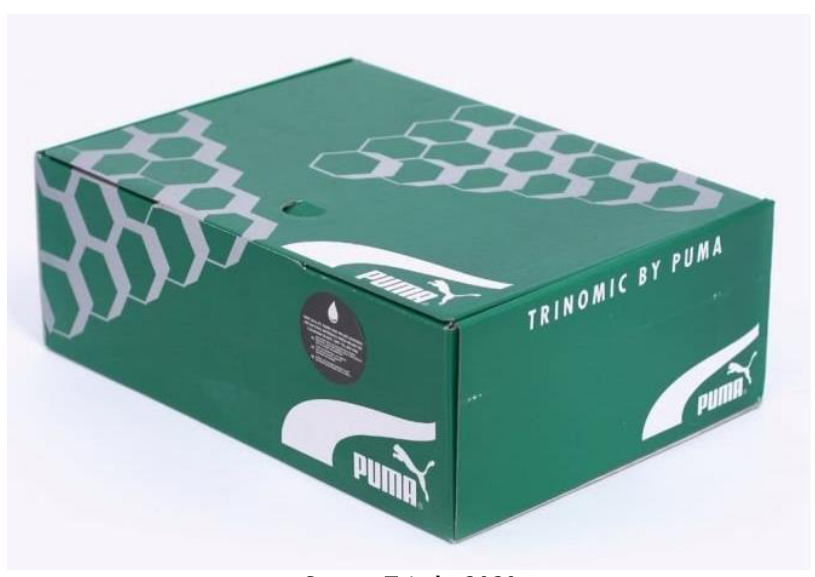
Figure 3: New PUMA box made from 95% recycled material